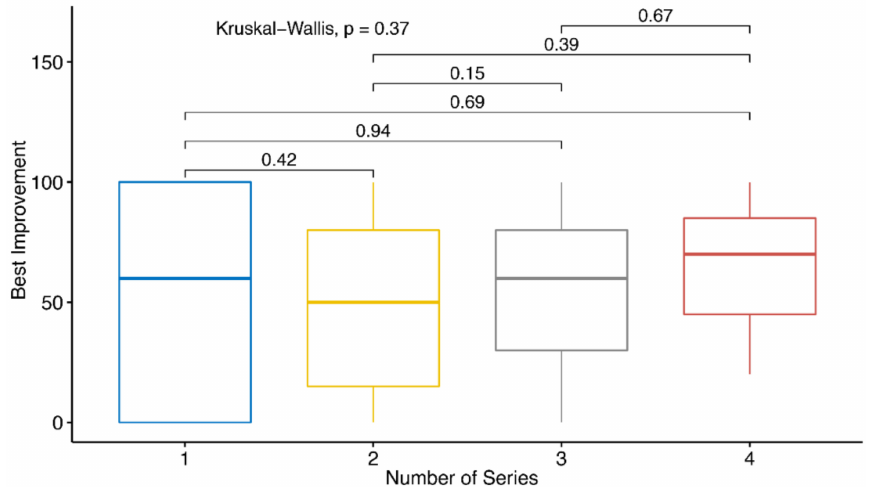
Figure 3. Therapeutic success in dependence of the number of series of LDRT applied. The Kruskal–Wallis Test was applied to compare the best improvement of patients in dependence of the number of radiation series (1, 2, 3 or 4) received. Here, the best percentage of improvement achieved was applied for the test independent of the time point of data